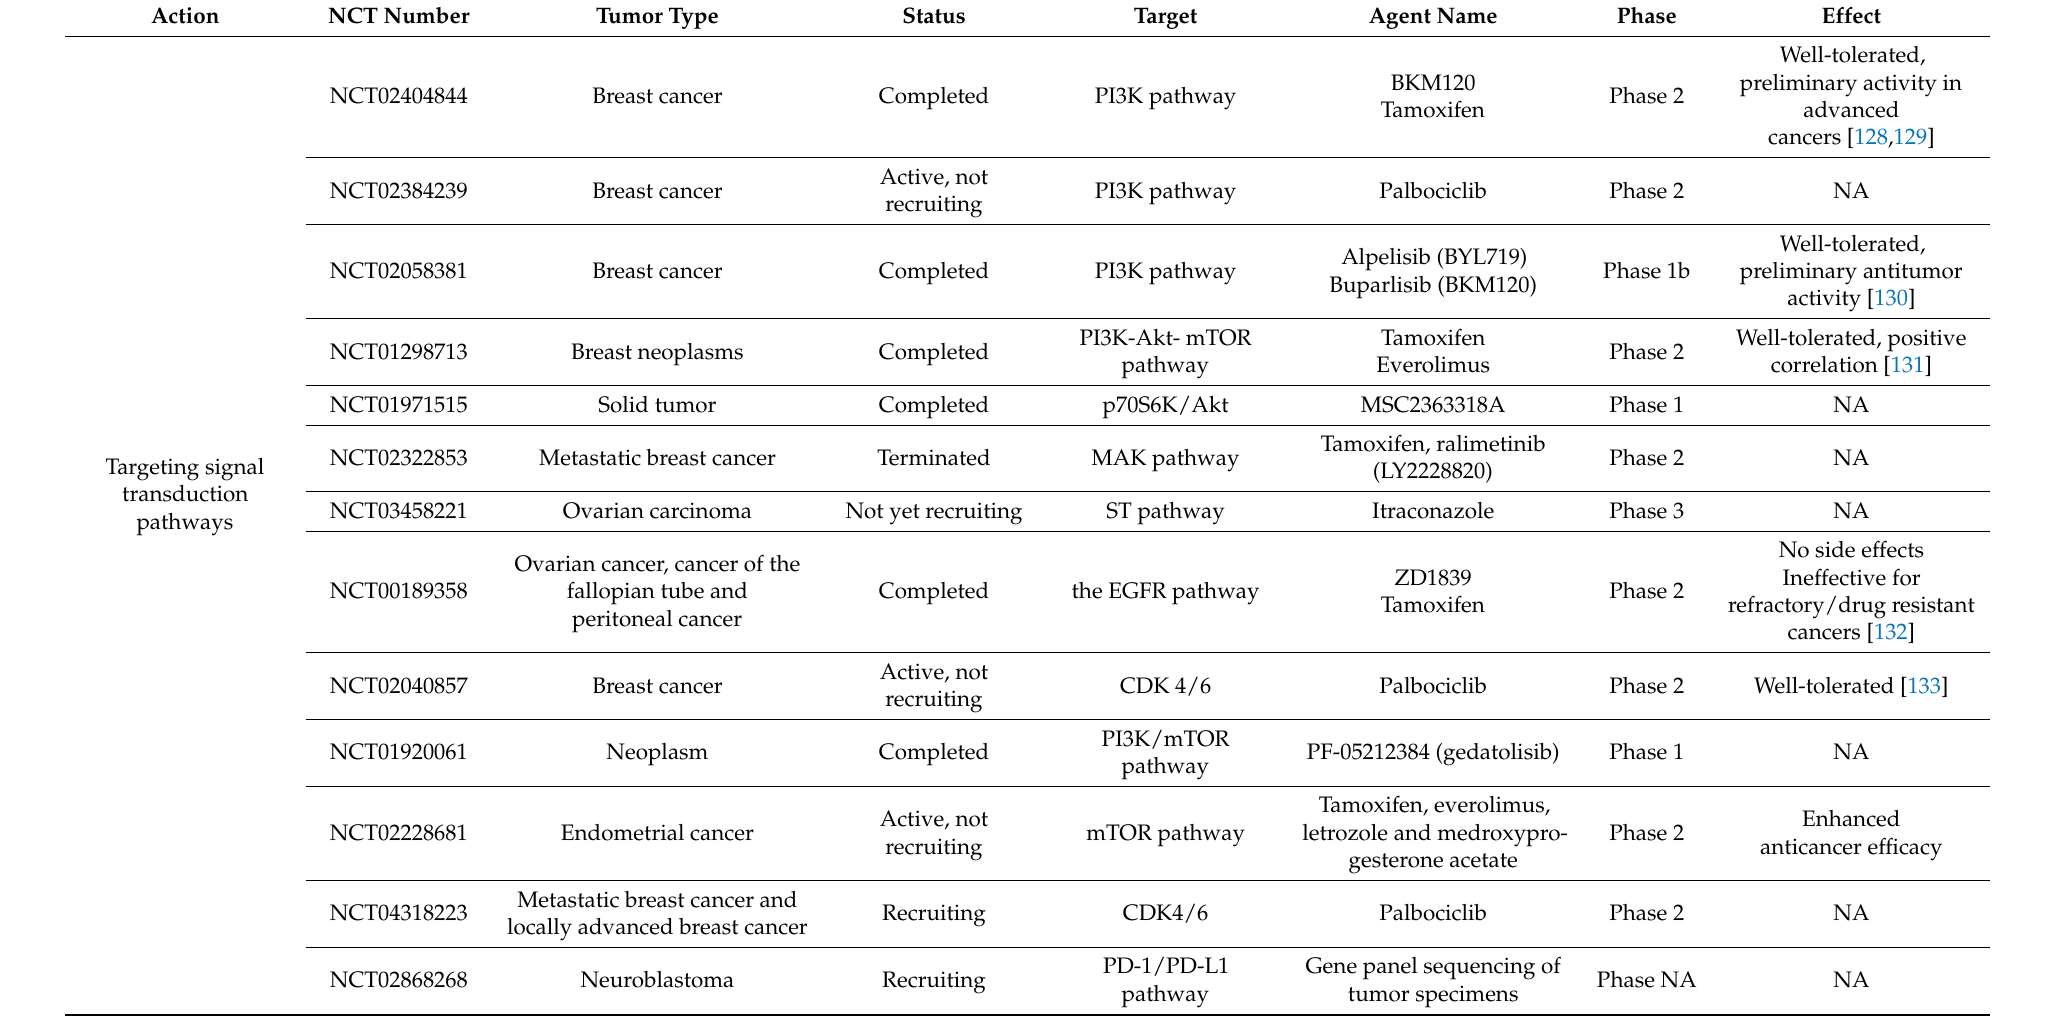
Table 1. Clinical trials of agents that target TAMs for cancer